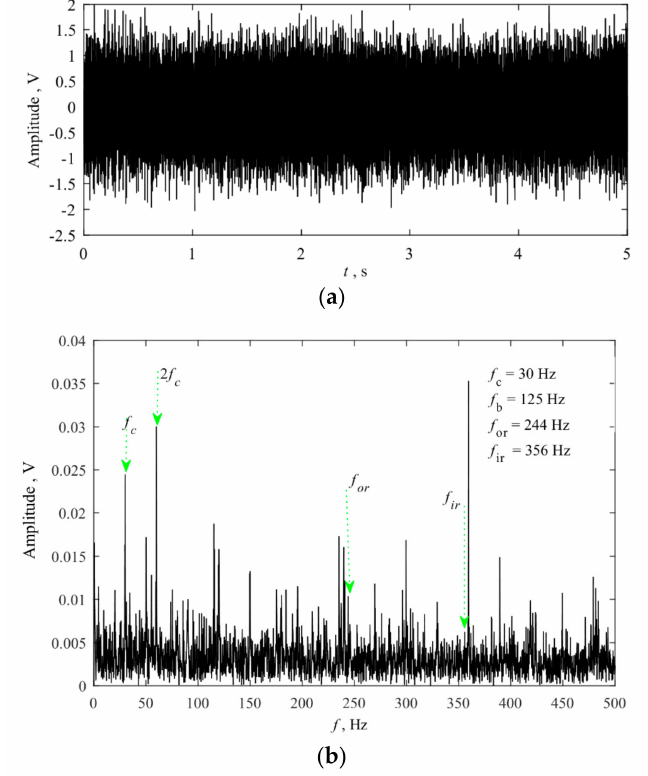
Figure 21. The vibration signal from MWA #7: ( a ) time domain waveform; ( b ) envelope